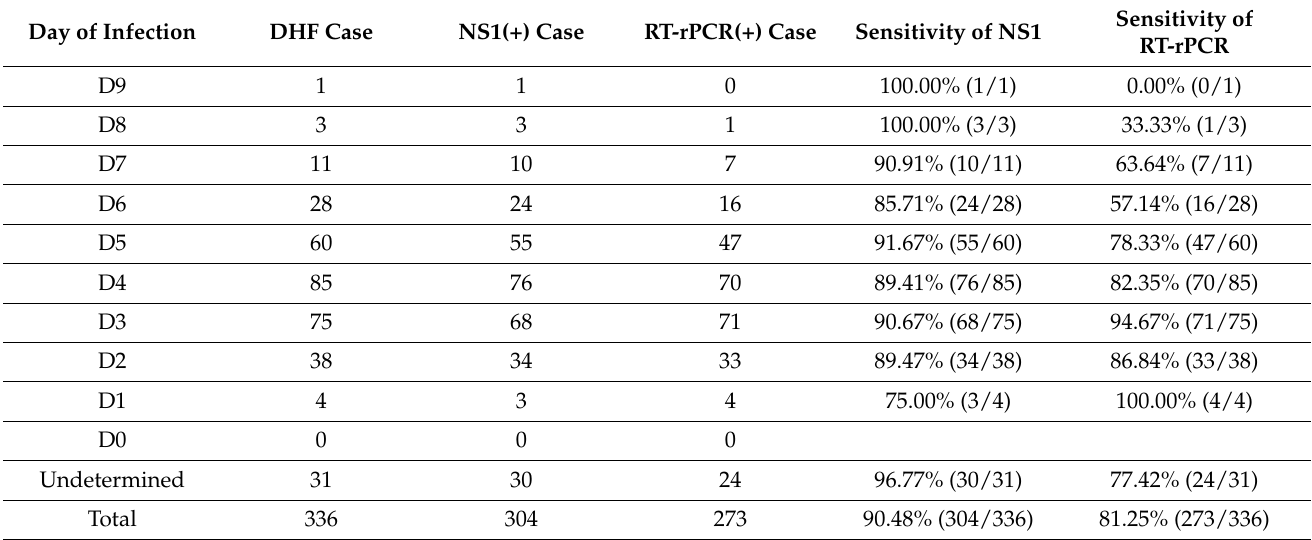
Table 2. The sensitivity of RT-rPCR and NS1 in diagnosis of DHF per day of infection.